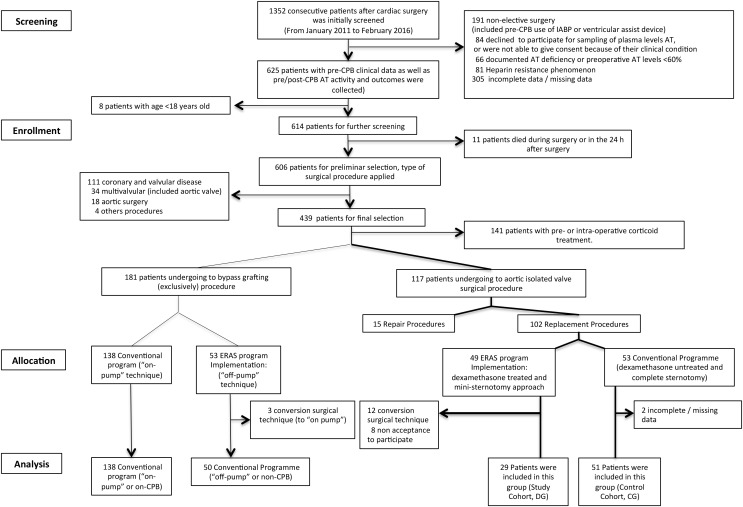
Flow diagram for the patient selection process.